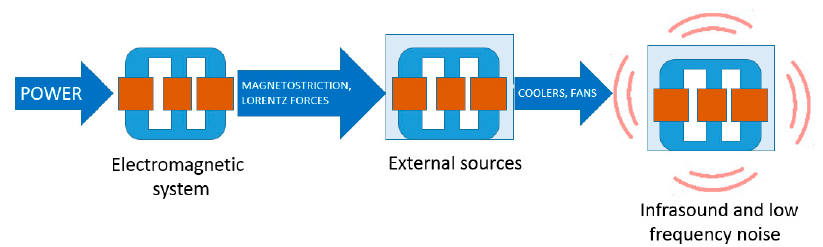
Figure 1. The process of the generation of noise from the vibration of a transformer.